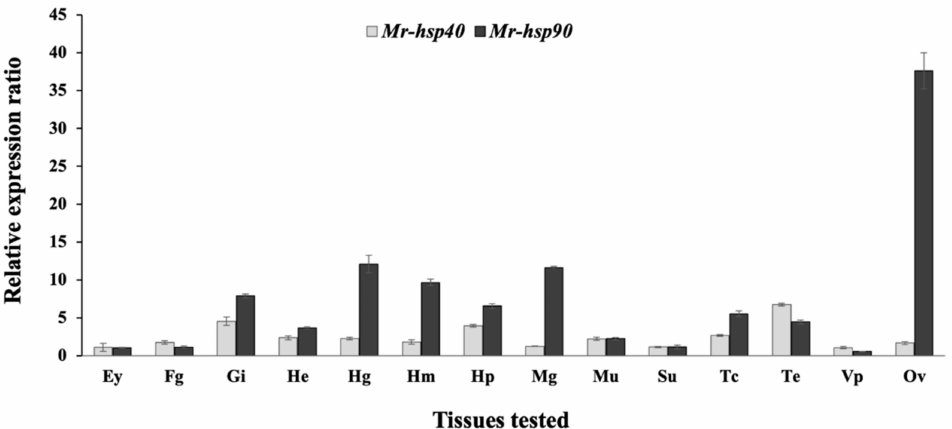
Figure 7. Expression analysis by qRT-PCR of the Mr - hsp40 and Mr - hsp90 genes. Ey = eyestalk, Fg = foregut, Gi = gills, He = heart, Hg = hindgut, Hm = hemocytes, Hp = hepatopancreas, Mg = midgut, Mu = muscle, Su = subcuticular epithelium, Tc = thoracic ganglia, Te = testis, Vp = vas deferens and Ov =